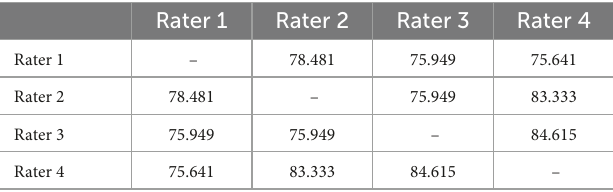
TABLE 5 Overall percentage agreement between raters for “include”/“uncertain”/“exclude”